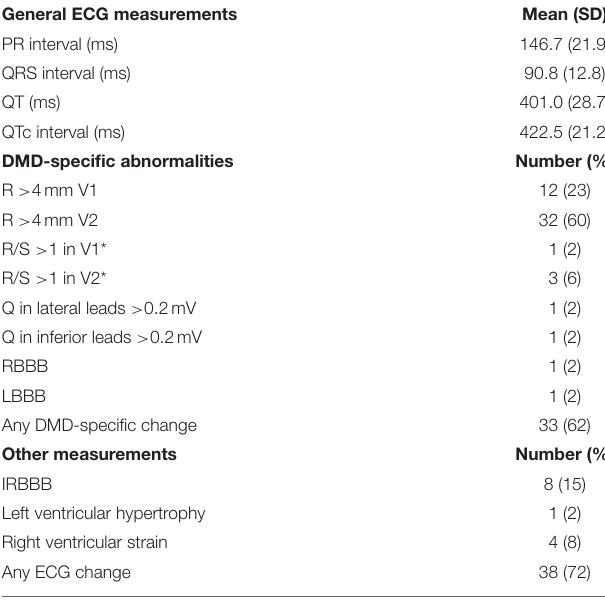
TABLE 3 | ECG findings in 53 women with pathogenic DMD